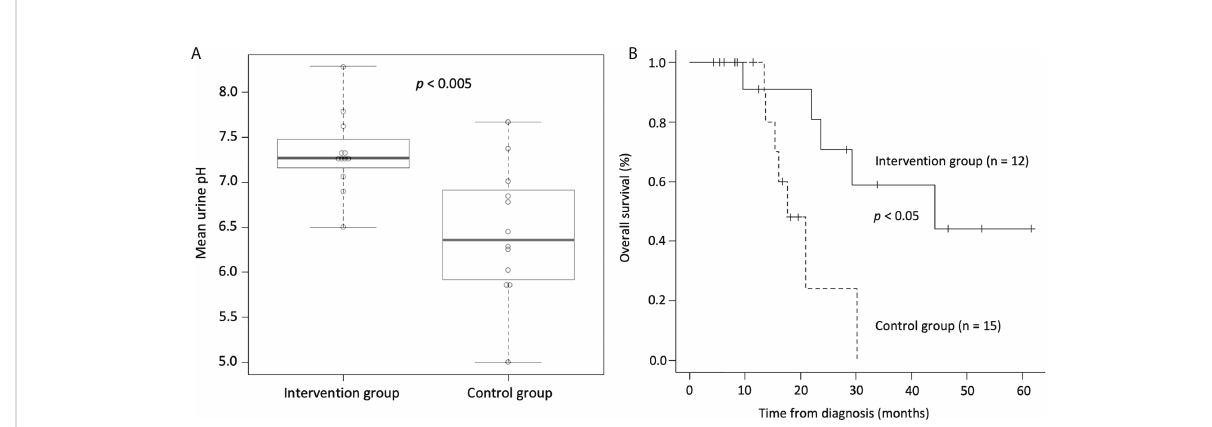
FIGURE 3 Urine pH and overall survival of small cell lung cancer patients who were treated with alkalization therapy plus vitamin C treatment together with chemotherapy and those who were treated with chemotherapy only. (A) Box-whisker plots of urine pH of the intervention group (alkalization therapy plus vitamin C treatment together with chemotherapy) and of the control group (chemotherapy only) are shown. Urine pH in the intervention group was signi fi cantly higher than that in the control group. The thick lines indicate the median values, the error bars indicate the maximum and minimum values, and the boxes indicate the values between the upper and the lower quartiles. (B) Kaplan – Meier curves of the OS of the intervention group and the control group are shown. The median OS of the intervention group was signi fi cantly longer than that of the control group. [Adapted from reference